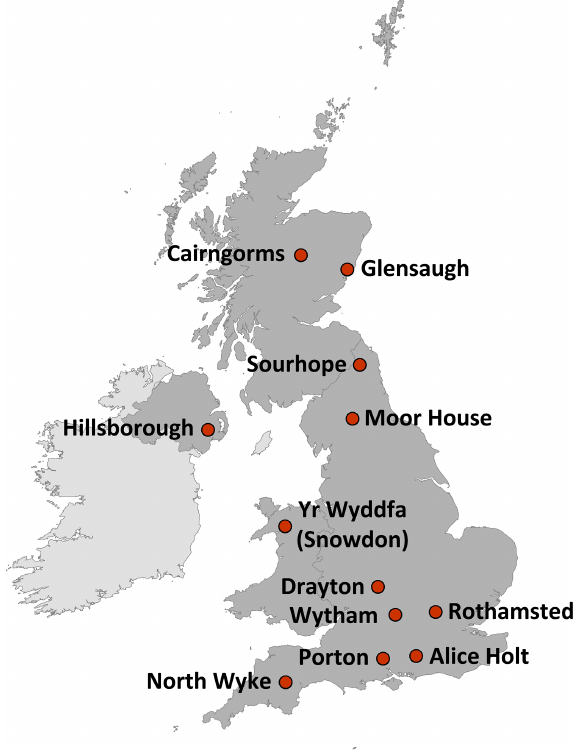
Figure 1. Locations of the ECN terrestrial